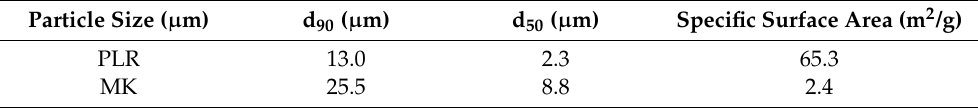
Table 1. The d 90 , d 50 , and specific surface area of raw